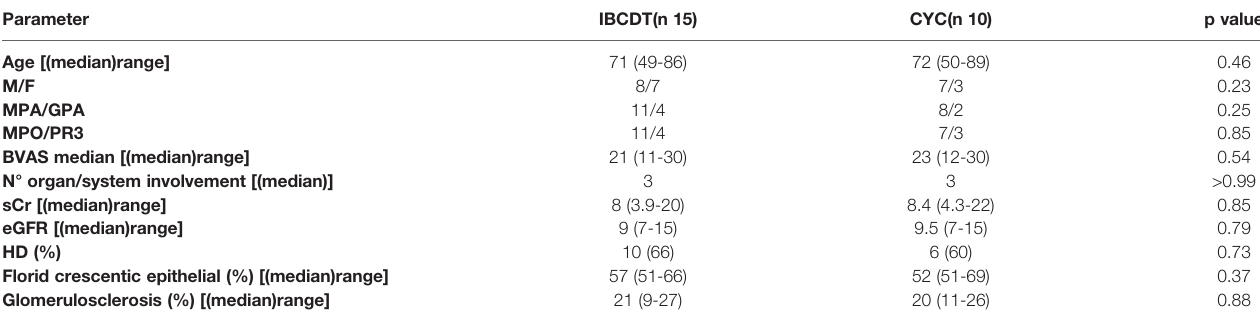
TABLE 1 | Baseline demographic and clinical characteristics of the study and control group. Parameter